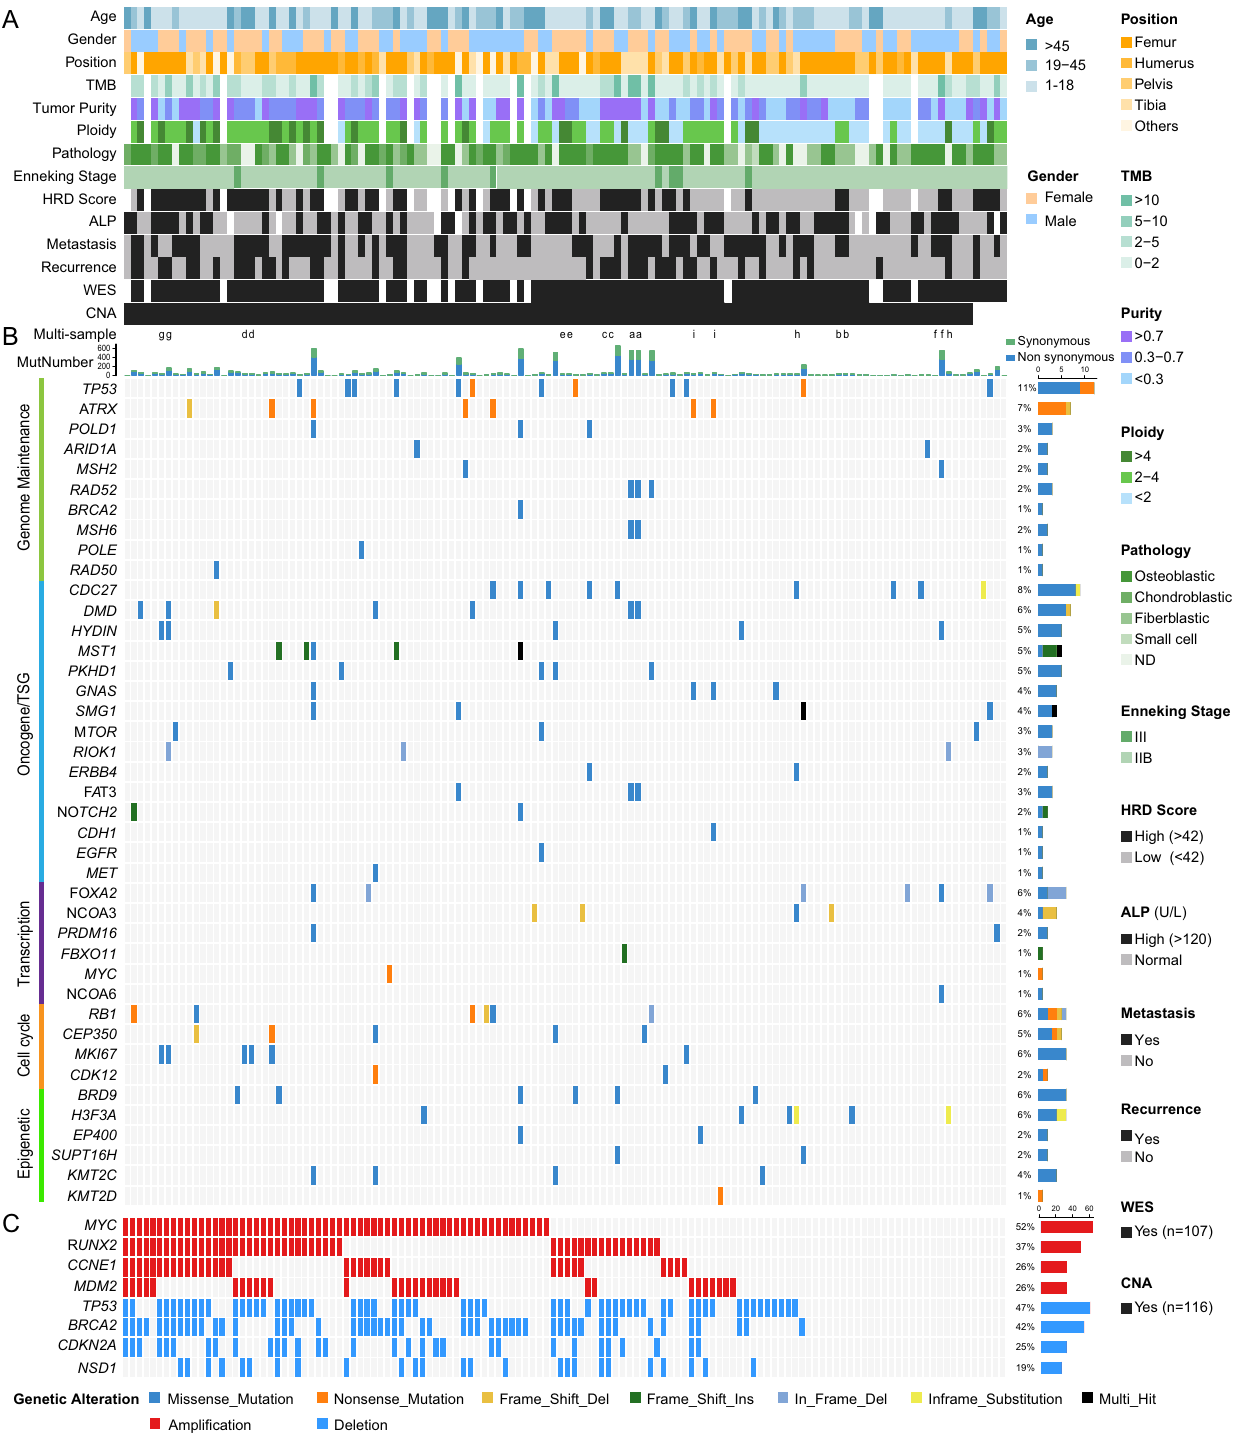
Fig. 1 | Genomic landscape of OS. Genetic pro fi le of SGH cohort patients. Each column corresponds to one sample (128 samples are displayed with 9 replicates). A Clinical information of age, sex, position, metastasis, recurrence, pathological classi fi cation, ALP (high: >120 U/ml) and clinical Enneking stages. Genetic infor- mation included TMB, HRD score (high: >42), ploidy and tumor purity. B Somatic